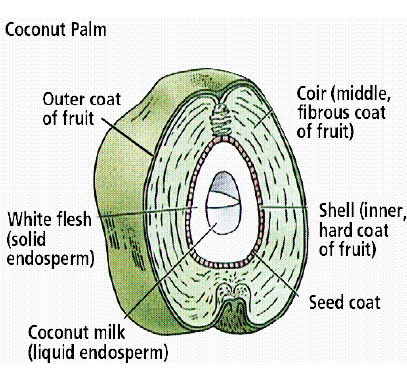
Figure 1 Internal view of Coconut